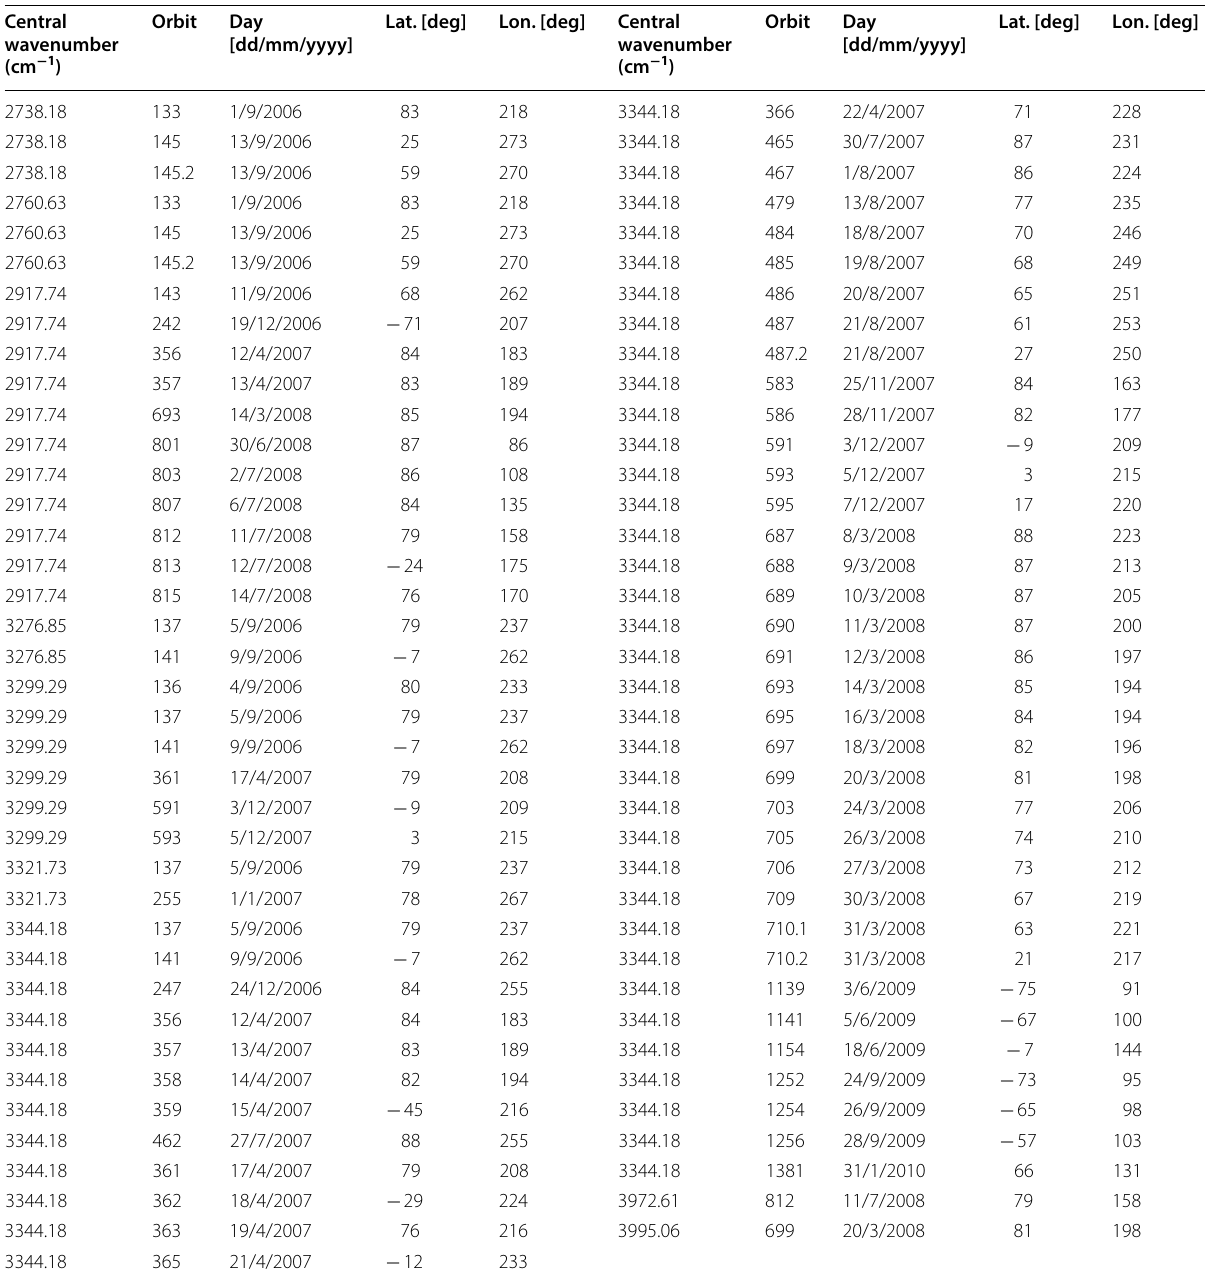
Table 2 Morning occultations employed in this study Central